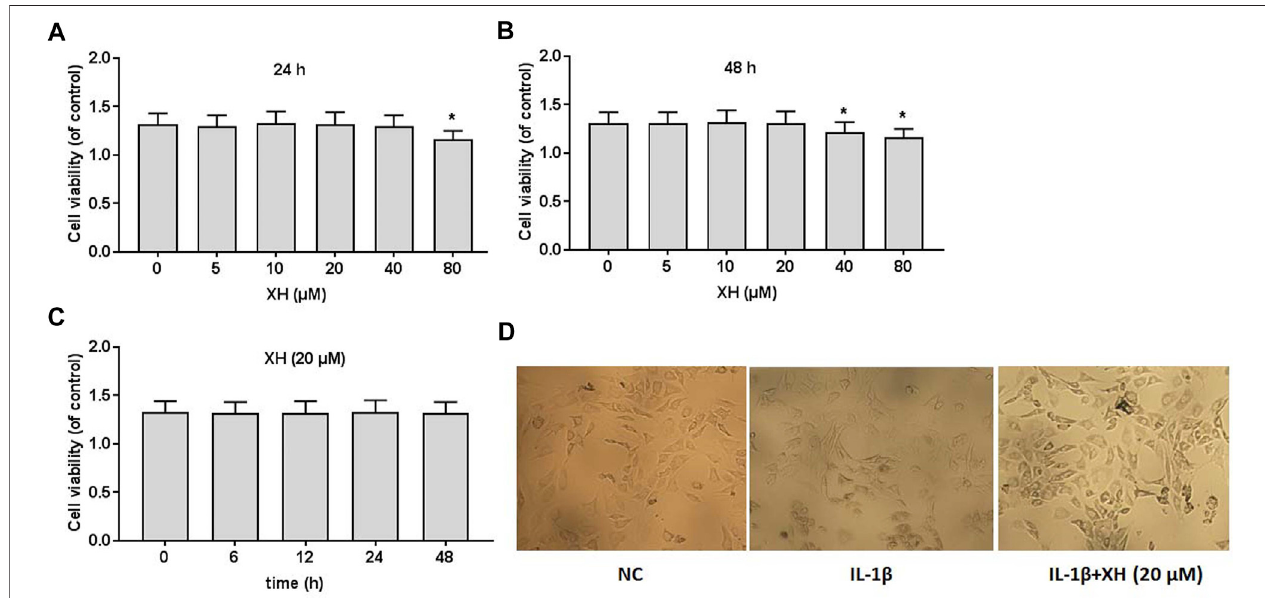
FIGURE2| CellviabilityofXH onratchondrocytes.CCK8 assayswereconducted todetermine theeffects ofXH(0, 5,10,20,40,and 80 μ M)in24 h (A) and48 h (B) ,respectively. (C) TheeffectsofXH(20 μ M)oncellviabilityin48 h. (D) ThecellmorphologywasobservedafteradministrationwithIL-1 β (10 ng/ml)withorwithoutXH (20 μ M) in 48 h. All experiments were performed in triplicate and data are presented as the mean ± standard deviation. * p < 0.05 and ** p <